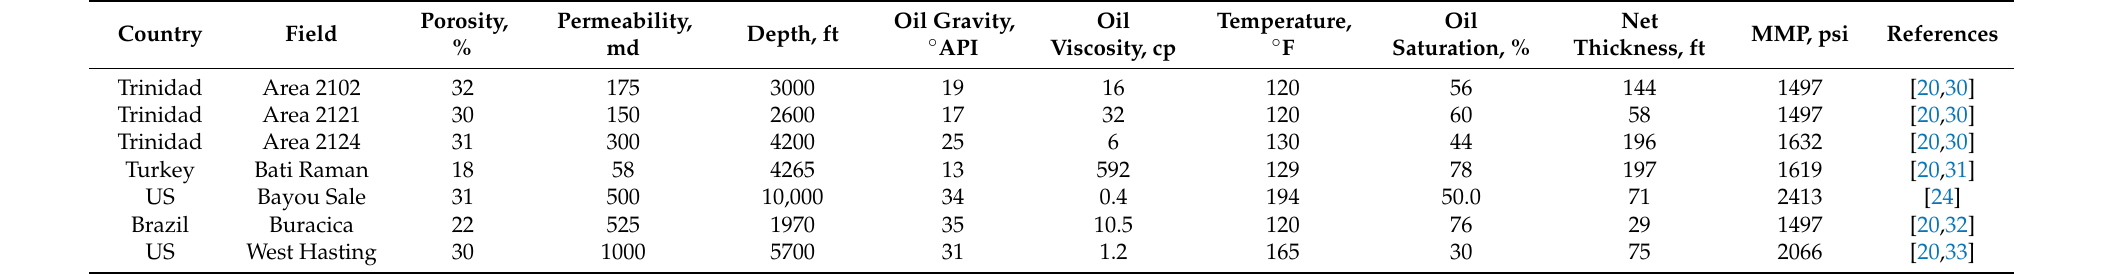
Table 7. Reservoir properties for implementation of immiscible CO 2 -EOR